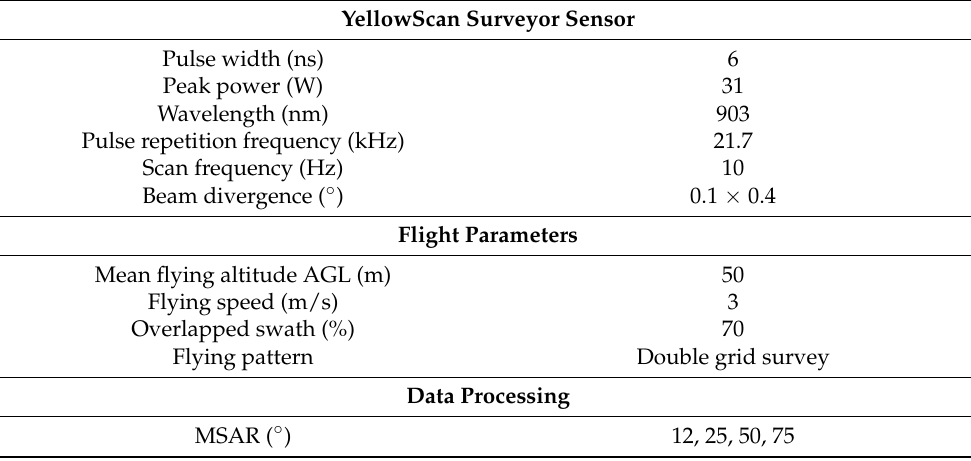
Table 1. Technical specifications of the sensor, flight parameters, and point cloud